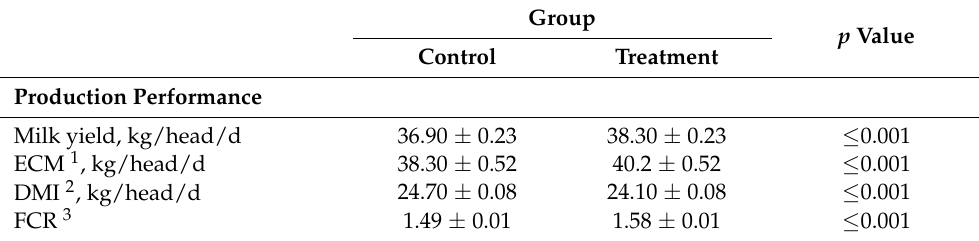
Table 7. Production performances in the Control and Treatment groups.